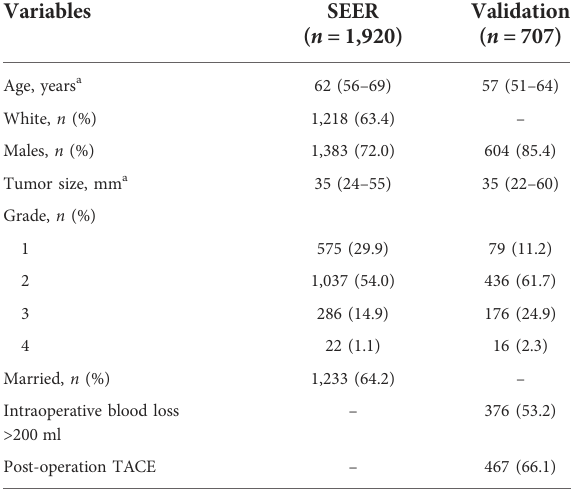
TABLE 1 Clinicopathological characteristics of SEER database cohort and validation